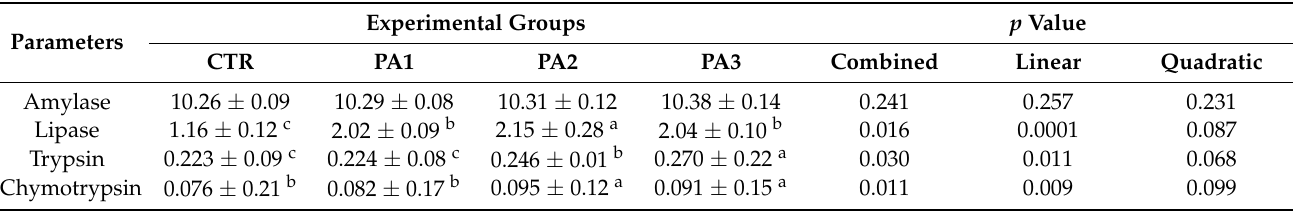
Table 6. The effects of P. australis extract (0, 100, 200, and 400 mg extract/kg diet) dietary administra- tion on intestinal enzyme activities (U/mg protein) of common carp for 56 days ( n = 9).